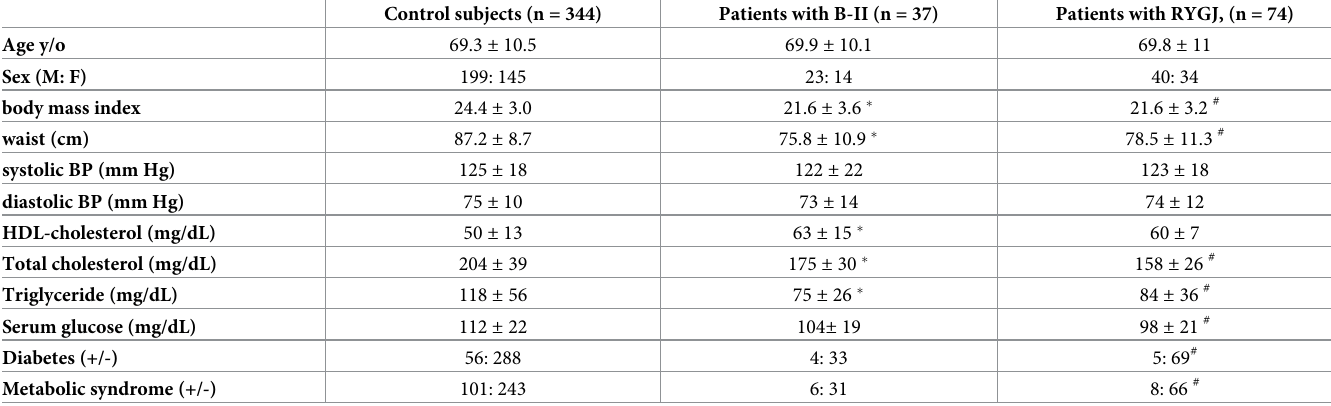
Table 2. Anthropometric and laboratory data between patients with subtotal gastrectomy and patients without gastric surgery with a median follow-up of 8.25 years. Control subjects (n = 344) Patients with B-II (n = 37) Patients with RYGJ, (n =